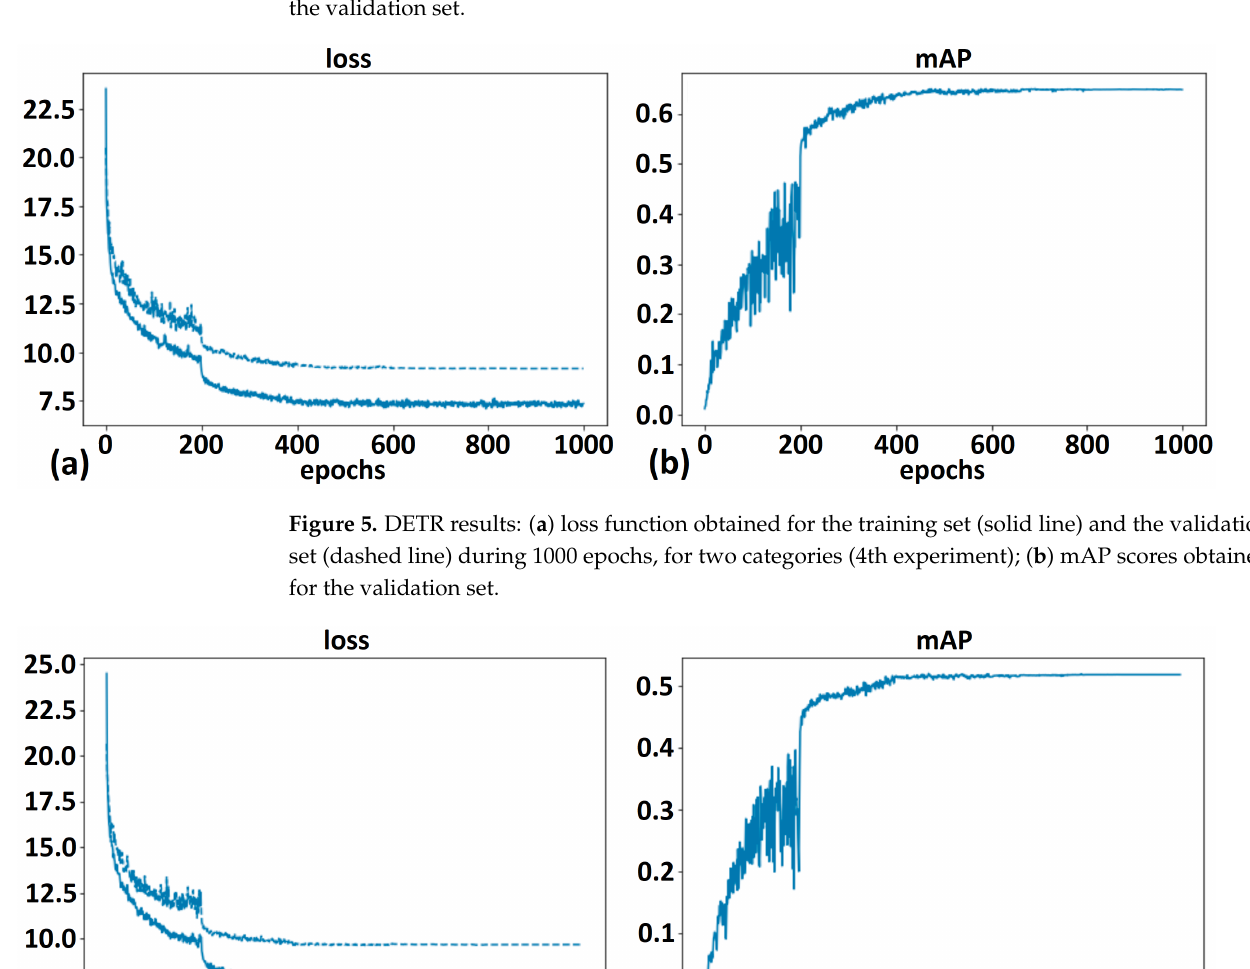
Figure 4. DETR results: ( a ) loss function obtained for the training set (solid line) and the validation set (dashed line) during 150 epochs, for all categories (2nd experiment); ( b ) mAP scores obtained for the validation set.